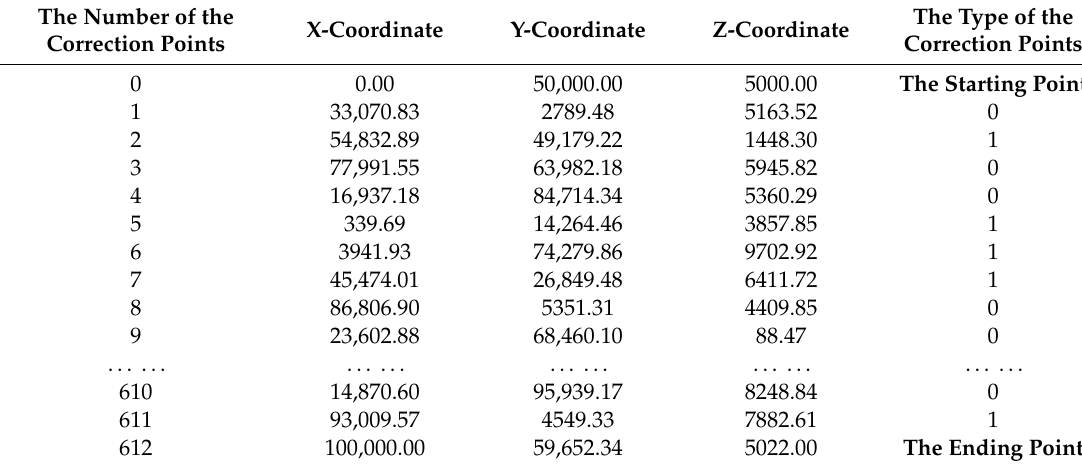
Table 1. Some data of the data set